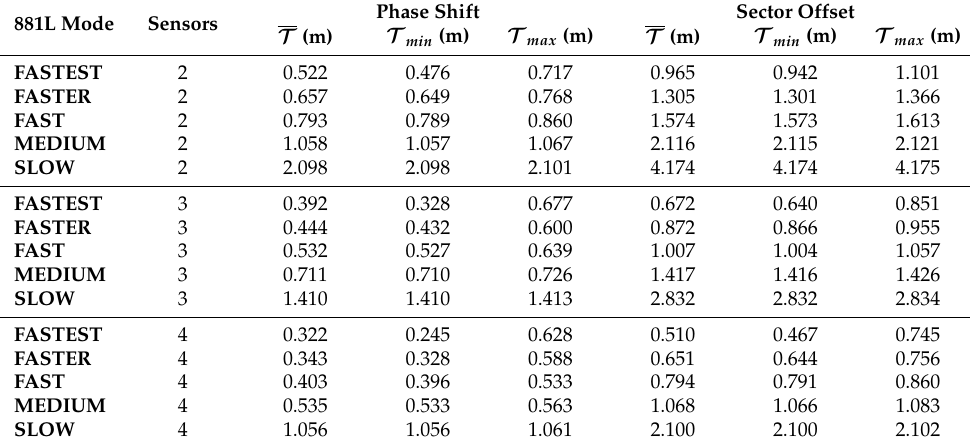
Table 5. Comparing Experimental data for multi-sensor approaches considering T , T min , T max , where T is a combination of T y and T y , which varies depending on T y